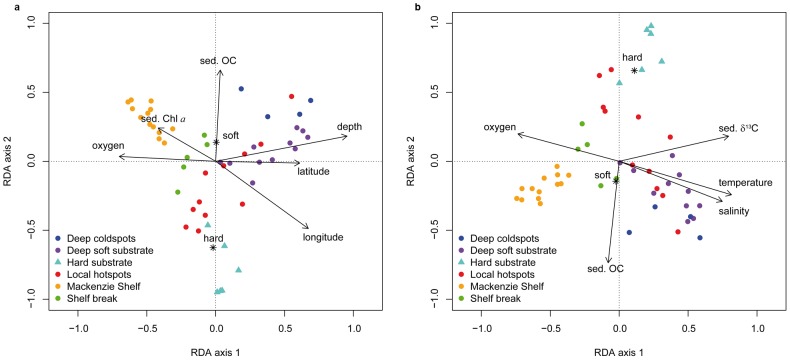
Redundancy analysis (RDA) ordination plots of megabenthic biomass-based taxonomic composition against forward selected environmental variables (black arrows and centroids) on 50 stations from 2008 to 2011.(a) Including indirect/spatial variables; the first two RDA axes explained 61% of the variance. (b) Without spatial variables; the first two RDA axes explained 64% of the variance. The categorical variable ‘substrate type’ is illustrated using centroids (*) for each category (hard and soft) and colors represent the six benthic communities defined in this study.